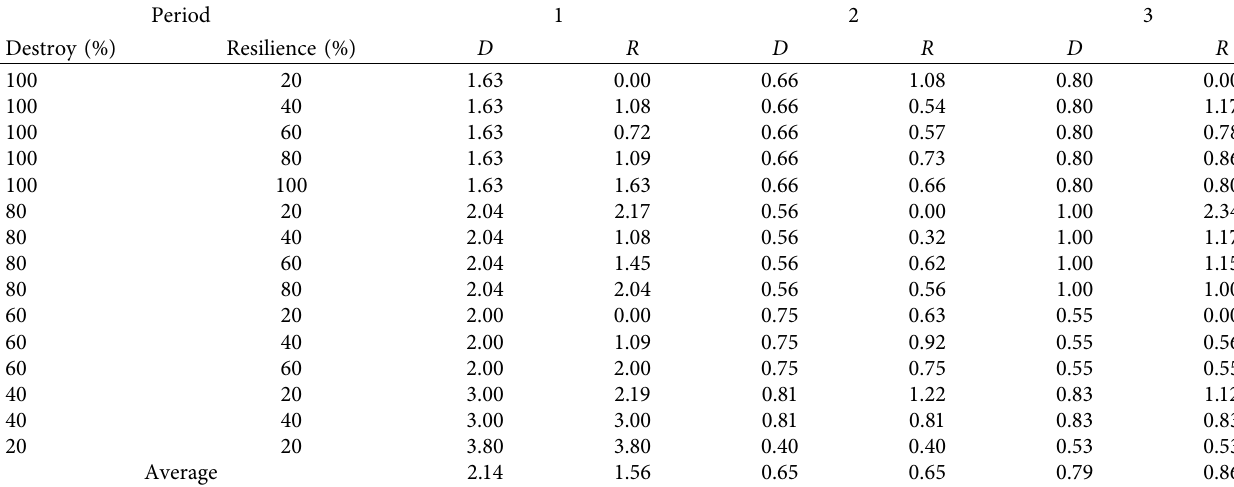
Table 4: Te average damage rate and average random recovery rate of the air trafc situation network in three periods. Period 1 2 3 Destroy (%) Resilience